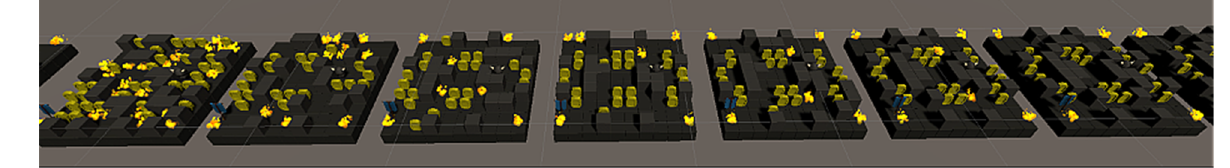
Figure 13. Intermediate evolution results (left to right).